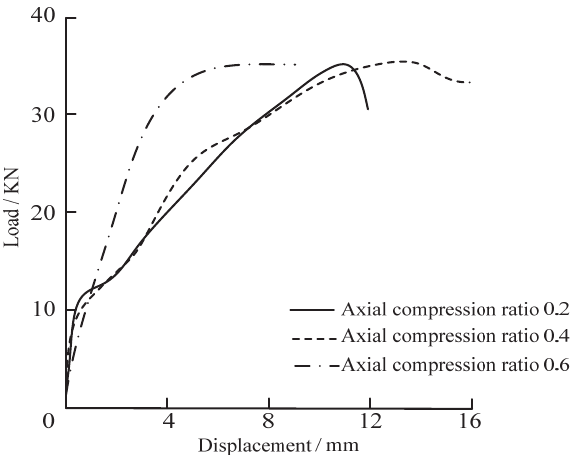
Figure 11: Curves of load-displacement (corrosion rate 0). Figure 12: Curves of load-displacement (corrosion rate 2%).